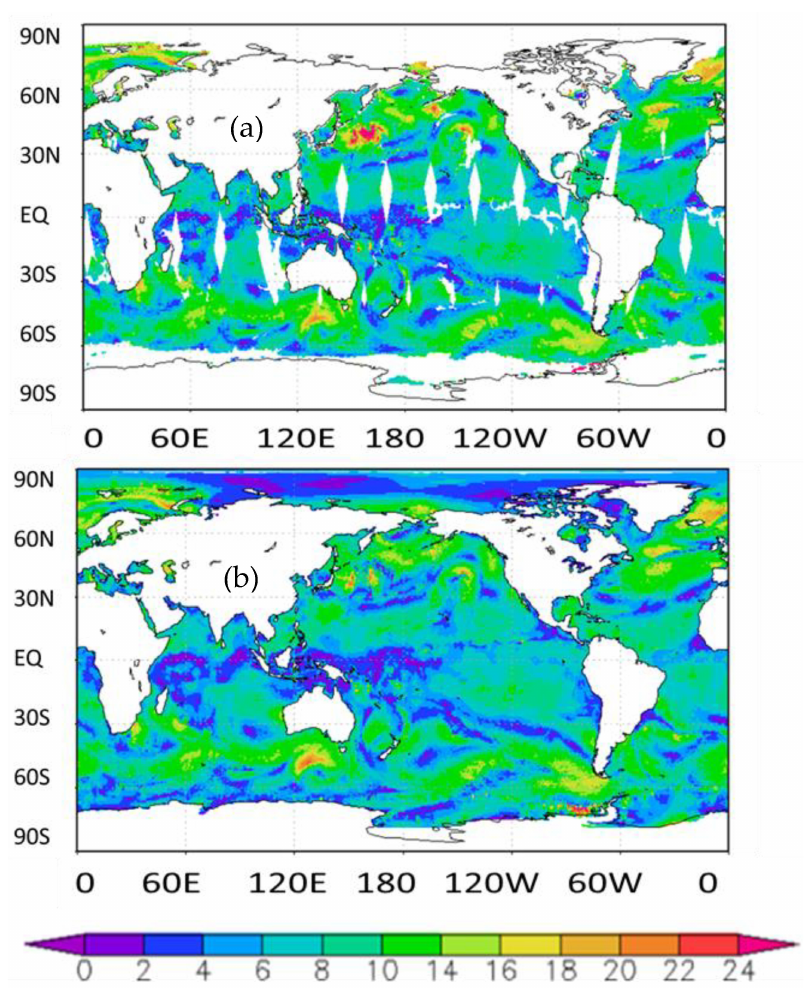
Figure 1. ( a ) L2B and ( b ) L4AW winds from SCATSAT-1 on 1 December 2018 (accessed on 15 August